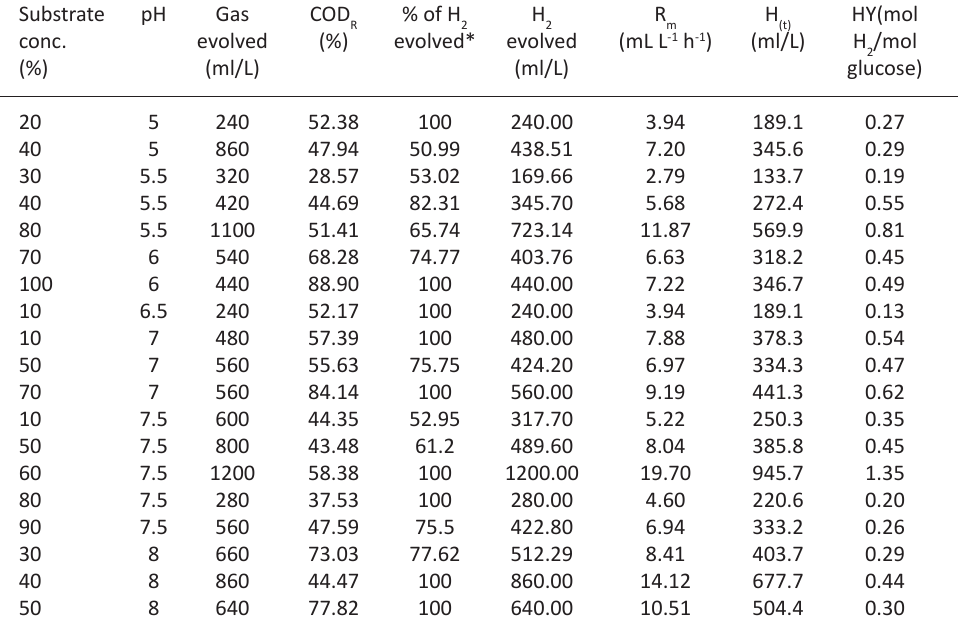
calculated based on GC analysis 2